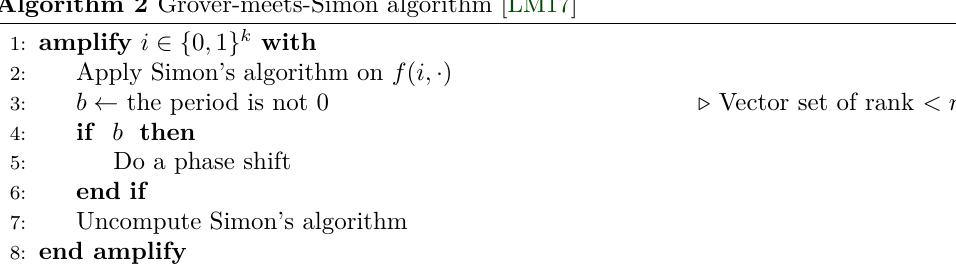
Algorithm 2 Grover-meets-Simon algorithm